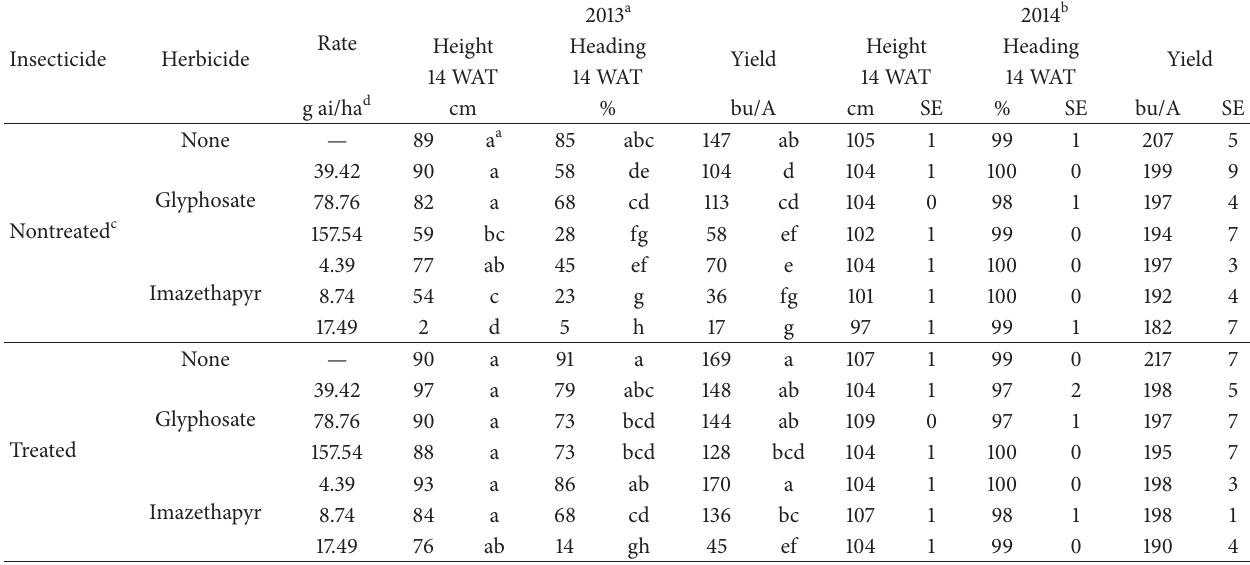
a Means followed by the same letter are not statistically different according to Fisher’s protected LSD ( 𝛼 = 0.05 ). b Timings that did not meet the assumptions of ANOVA are reported as means followed by the standard error of the mean (SE). c “Nontreated” meansthericeseedreceivedfungicideonlyandnoinsecticideseedtreatment whereas“treated”meansthericeseedwastreatedwith198g/45kg of CruiserMaxx Rice. d Glyphosate rates are in “g